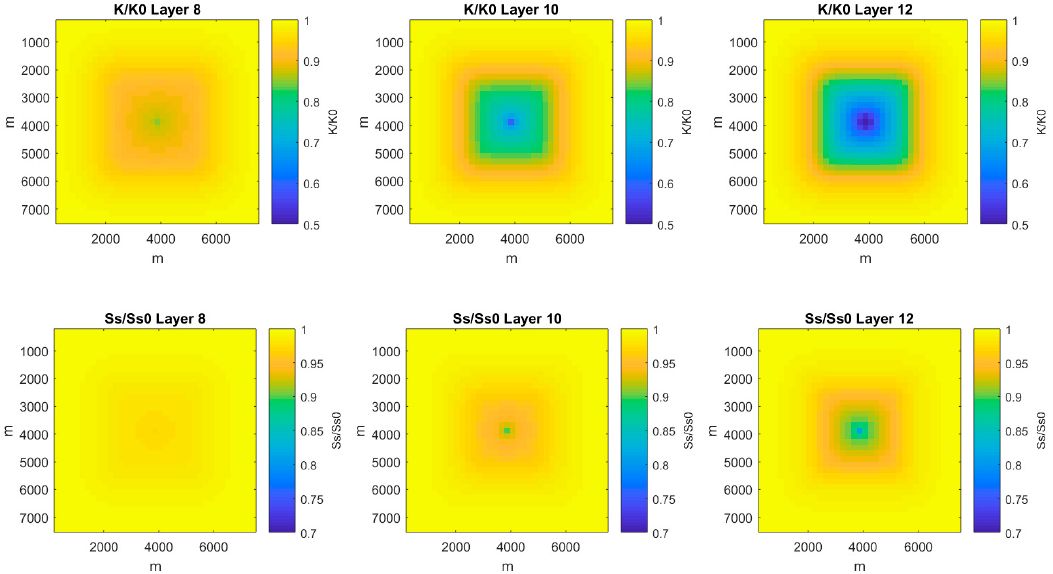
Figure 8. Change in hydraulic conductivity and specific storage at the top (layer 8), middle (layer 10), and bottom (layer 12) of the second confining layer, unit D. A homogeneous highly compressible formation, unit D in this case, is transformed to a horizontally and vertically heterogenous one.